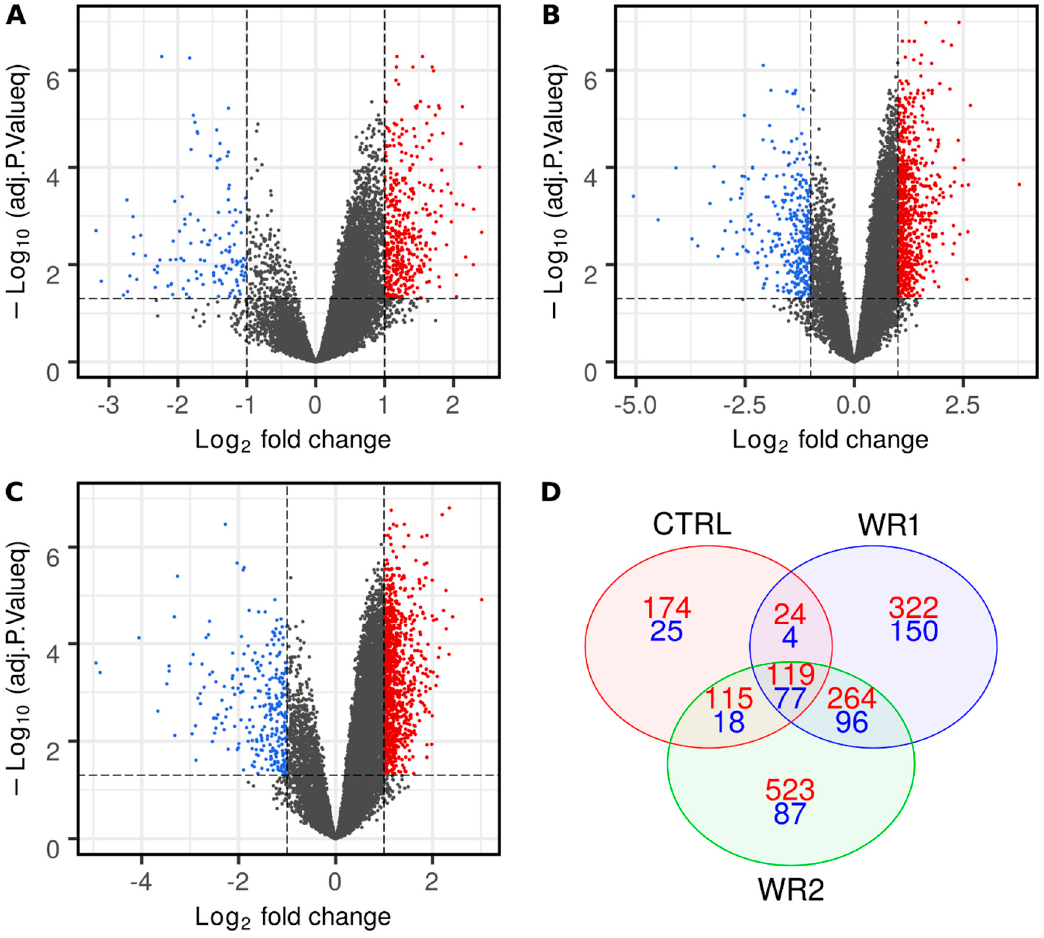
Figure 1. Differentially expressed (DE) gene analysis between 6 and 24 h in each condition separately. Volcano plots represents the distribution of DE genes between 6 and 24 h for the control (CTRL) ( A ), WR1 ( B ) and WR2 ( C ) groups. Lines separate logFC > 1 and adj. p value < 0.05. Venn diagram of the distribution of DE genes between 6 and 24 h in each condition with logFC > 1 ( D ). Red color represents upregulated genes, and blue, downregulated genes.